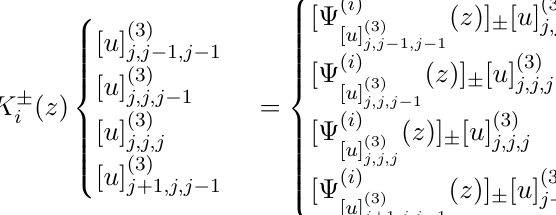
(a) Basis of one-dimensional crystal represen- tation ‘ . 2 Figure 44. Basis and coordinates of the one-dimensional crystal representation ‘ 2